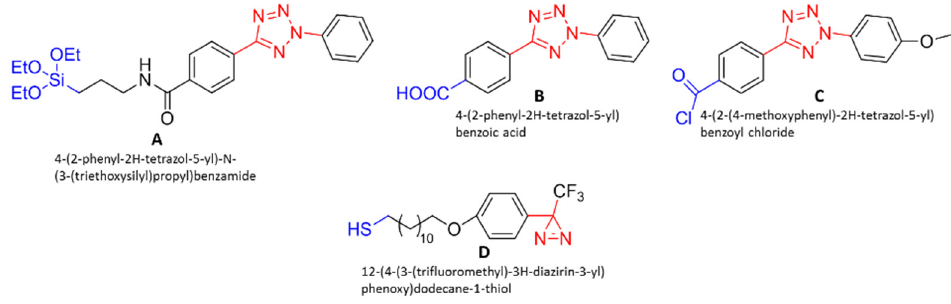
Figure 17. Tetrazole and diazirine compounds (red) which can be covalently coupled to surfaces using anchor moieties (blue).